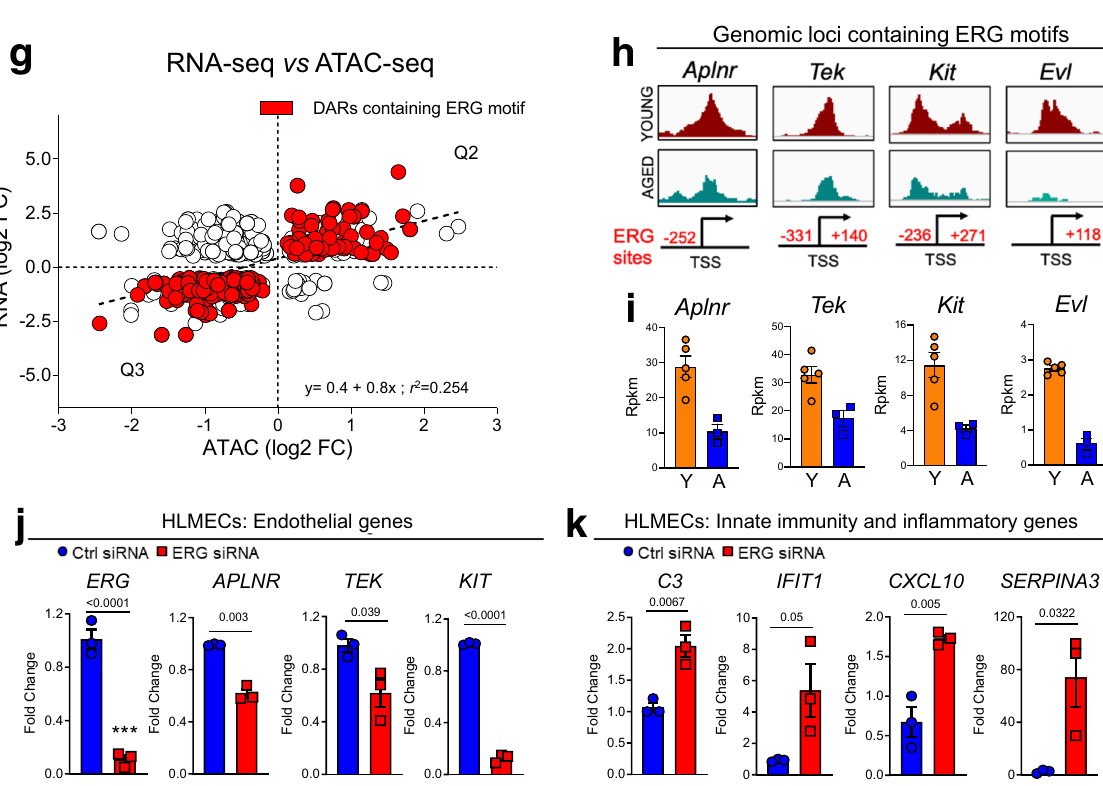
uninjured young ones. To this end, we focused on three distinct gene categories that feature in different phases of the angiogenesis process: “ Proliferation ” , “ Cytoskeleton & Cell migration ” , and “ Basement membrane formation 31 ” . Although we did not observe signi fi cant differences in the expression of genes implicated in cell proliferation between injured young and injured aged lung ECs (Fig. 4f), the expression of genes implicated in cytoskeleton & cell